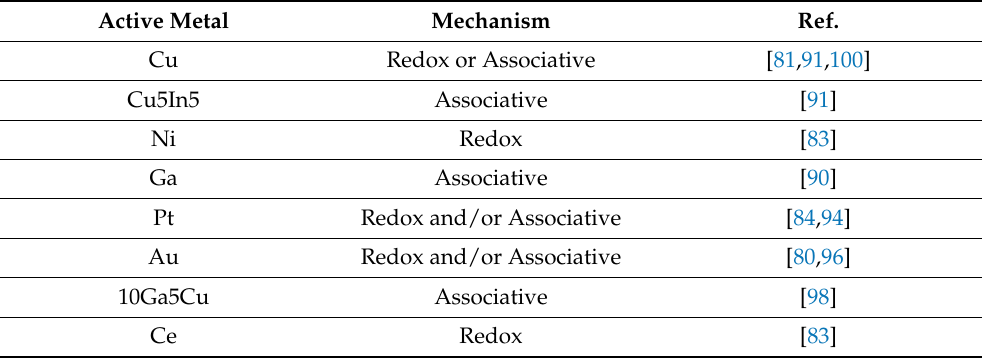
Table 1. Dominated mechanism in RWGS reaction based on different kinds of metal-CeO 2 . Active Metal